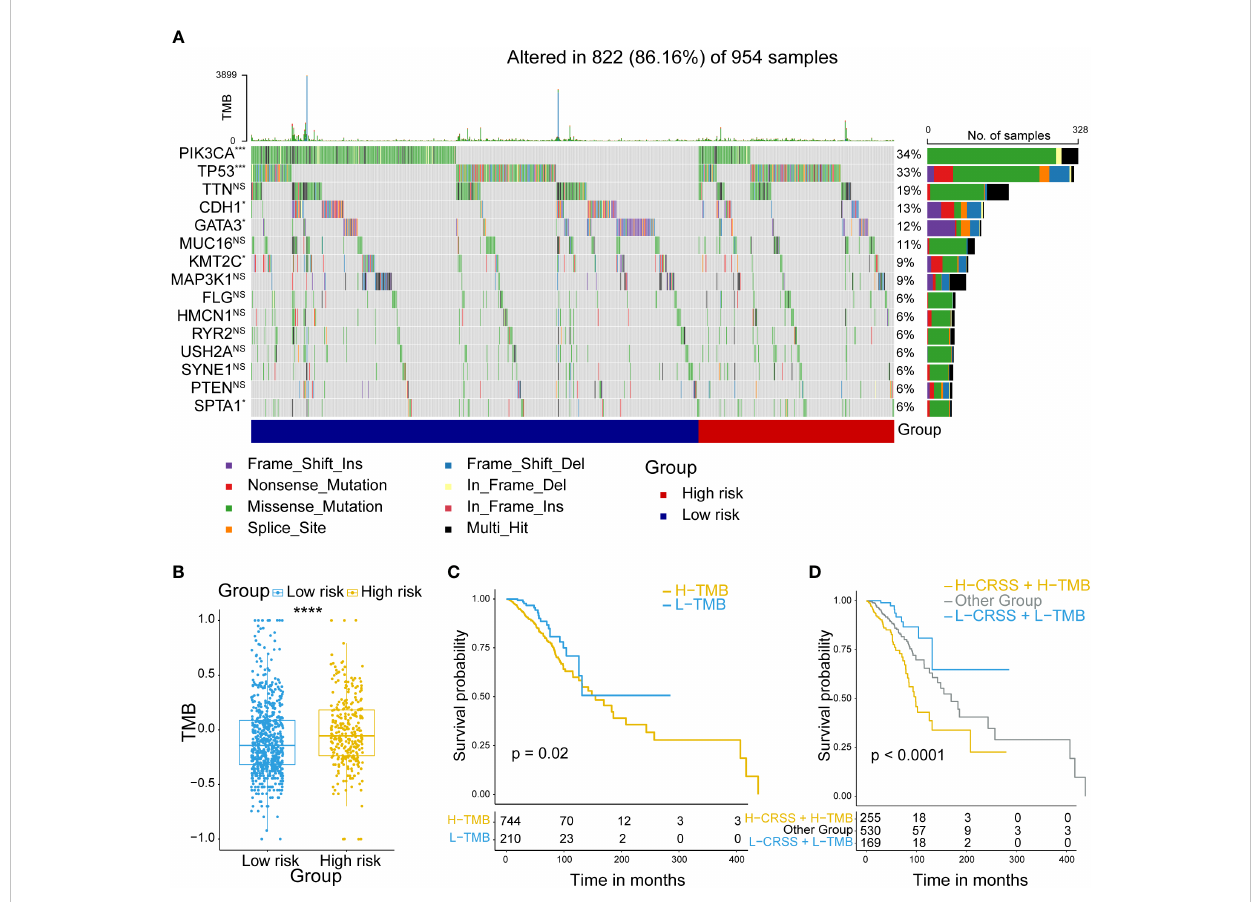
FIGURE 4 Mutation analysis of centrosome-related prognostic model. (A) Comparison of the mutation landscape between groups with high/low-risk. (B) Tumor mutant burden (TMB) difference among groups with high/low-risk. (C) Kaplan-Meier analyses of OS in breast cancer patients, strati fi ed according to TMB values. (D) Kaplan-Meier analyses of OS in breast cancer patients strati fi ed according to the combination of CRSS and TMB. The asterisks represent the statistical P value (****p <